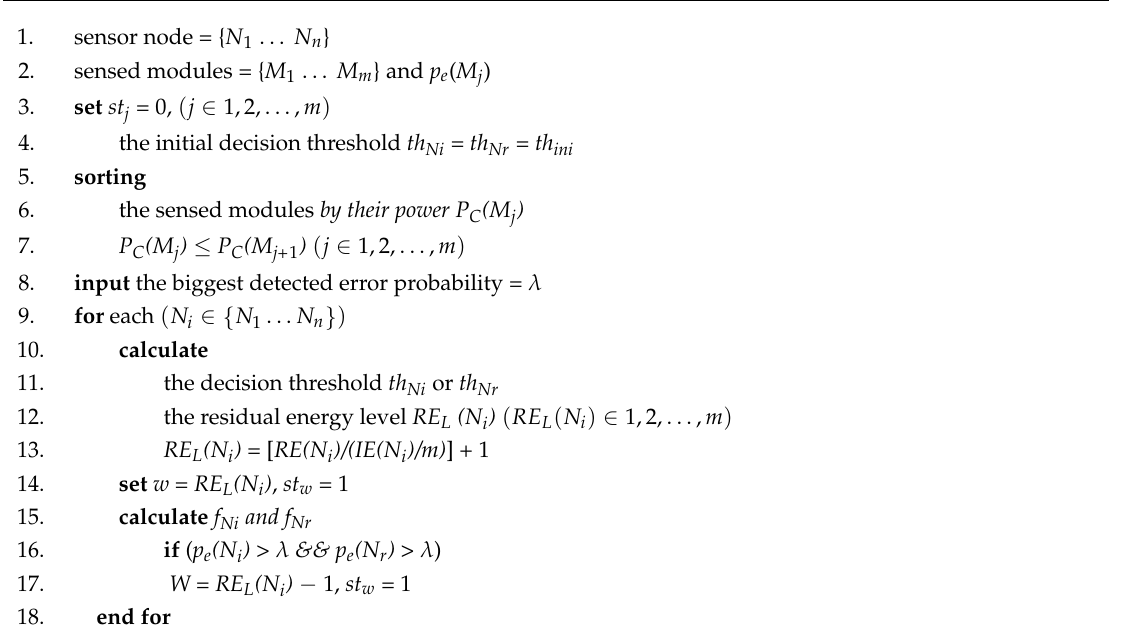
Algorithm 1. Sensed modules selection in surveillance